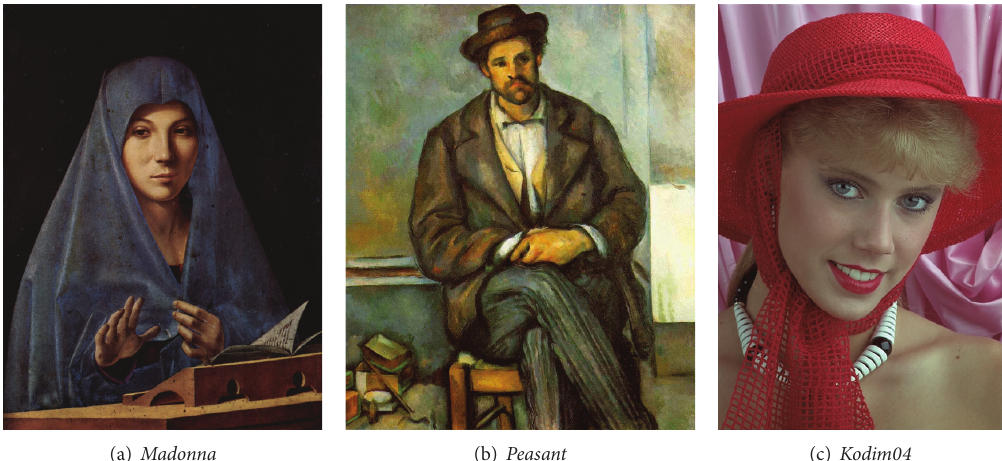
Figure 10: Original images used for mosaic generation: Madonna ( 1012 × 1351 ), peasant ( 910 × 1106 ), and Kodim04 ( 512 × 768 ).